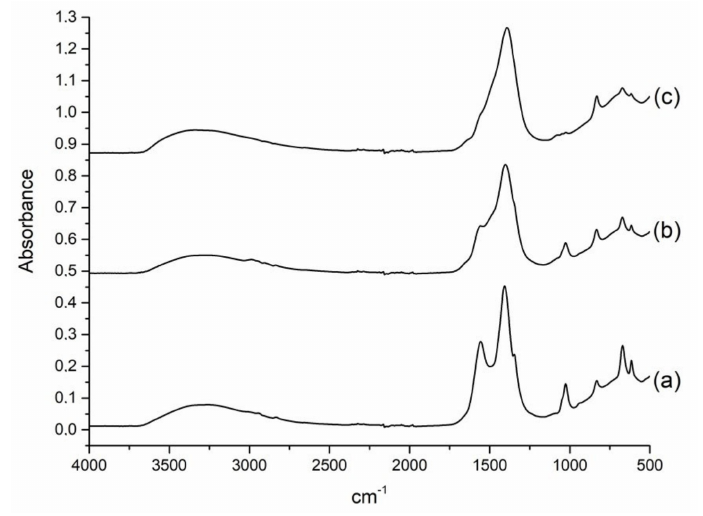
Figure 2. ATR FTIR spectra of the SAS-precipitated precursors of Co2Ni1 samples obtained with different water content: Co2Ni1_W0 ( a ); Co2Ni1_W4 ( b ); Co2Ni1_W8 ( c